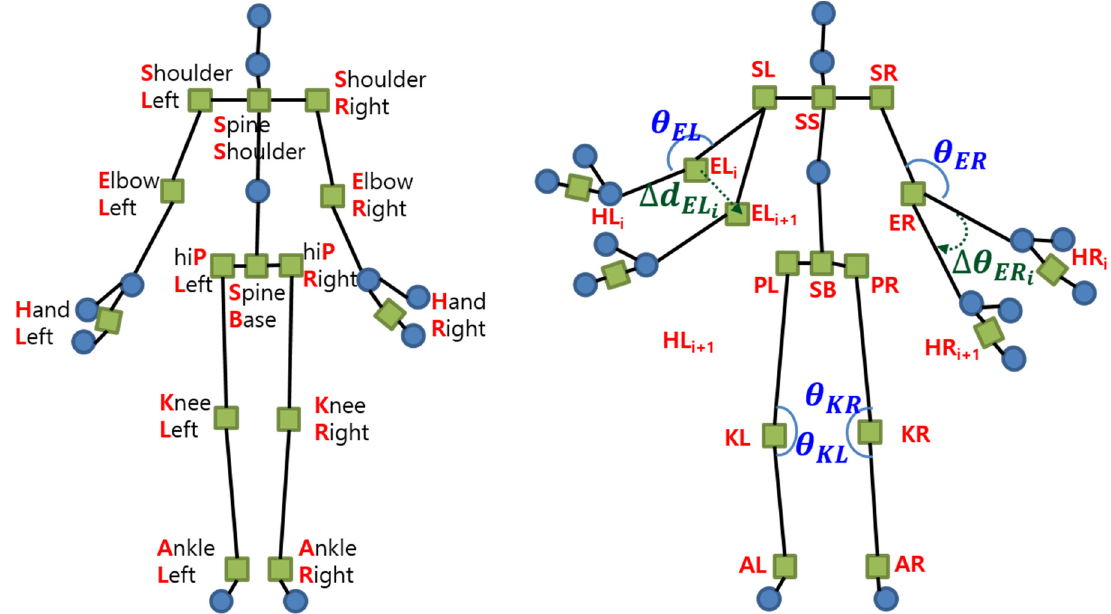
Figure 4. Kinect-based skeleton model for exercise.